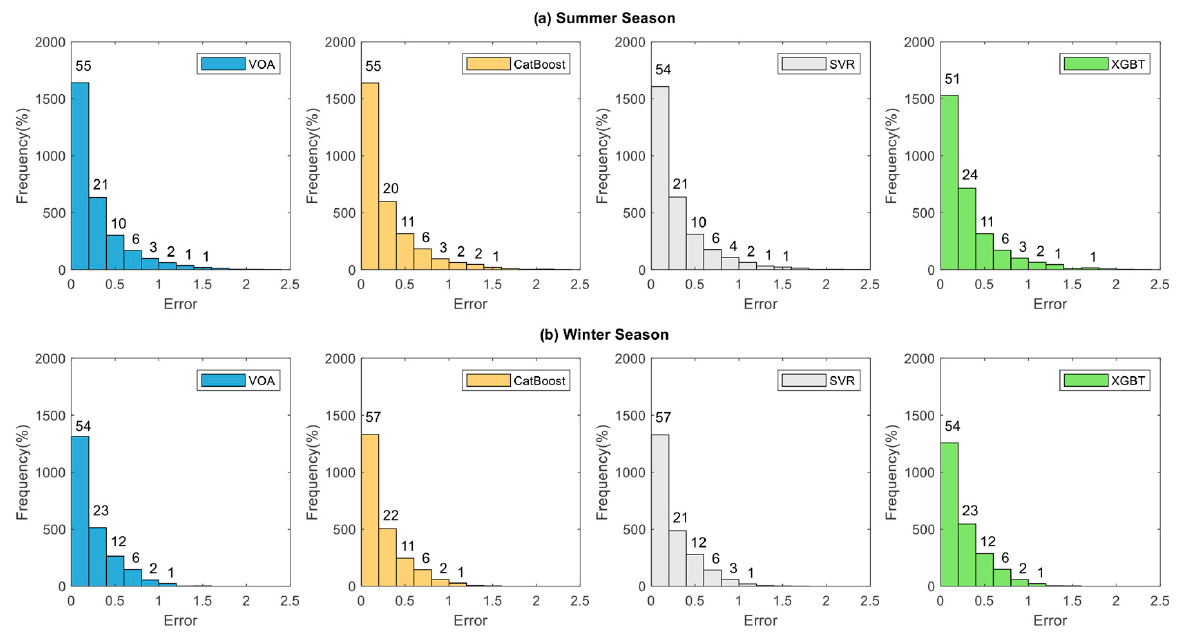
Figure 8. Histogram of the absolute error for all ML algorithms. ( a ) Summer. ( b ) Winter.